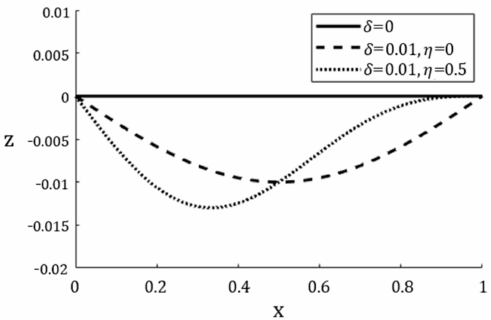
Figure 6. The support phase trajectory. In function expression, different amplitudes δ and η can be set to achieve the ideal support phase position control; we adopted δ = 0.01 and η = 0.5 in this